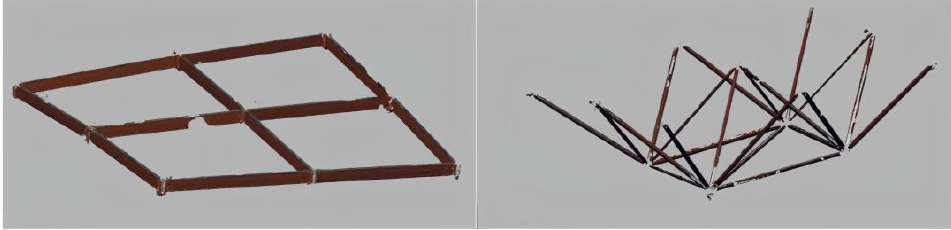
Figure 35. The mesh reconstruction examples for the classes of rectangular and tubular beams.